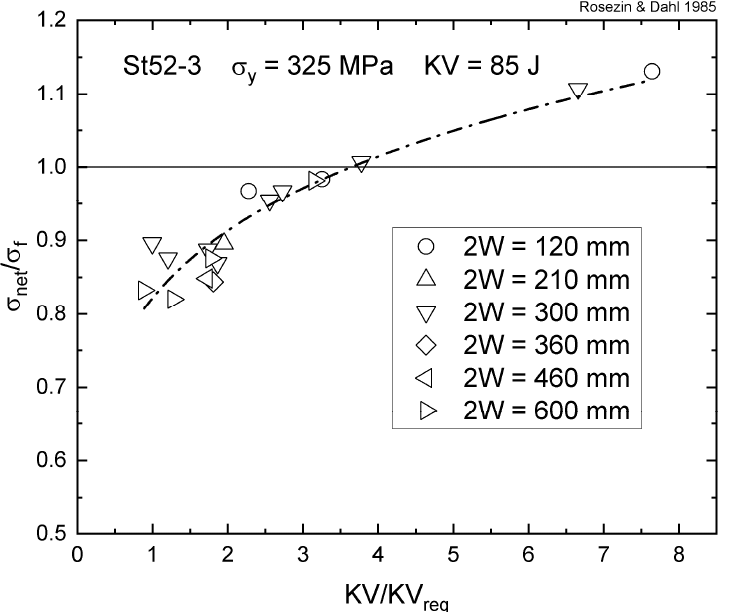
Figure 15. Compilation of proportional net section stress divided by flow stress as a function of ratio between the Charpy-V impact energy and estimated required impact energy to obtain the plastic limit load for the second St52-3